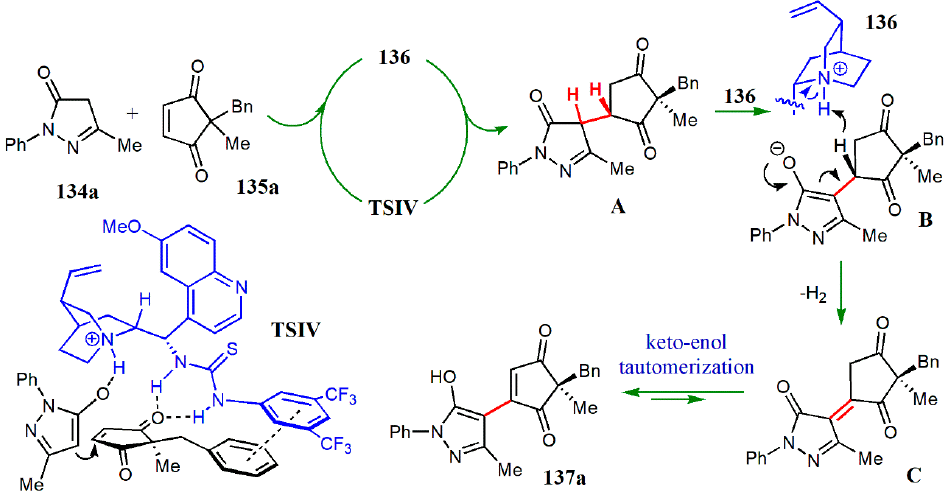
Figure 46. The mechanism proposed for the desymmetrization of cyclopentenediones.